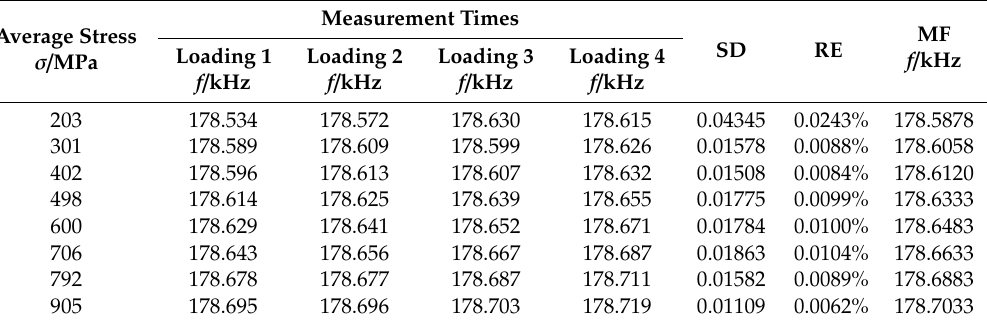
Table 3. The experimental data—5 m.